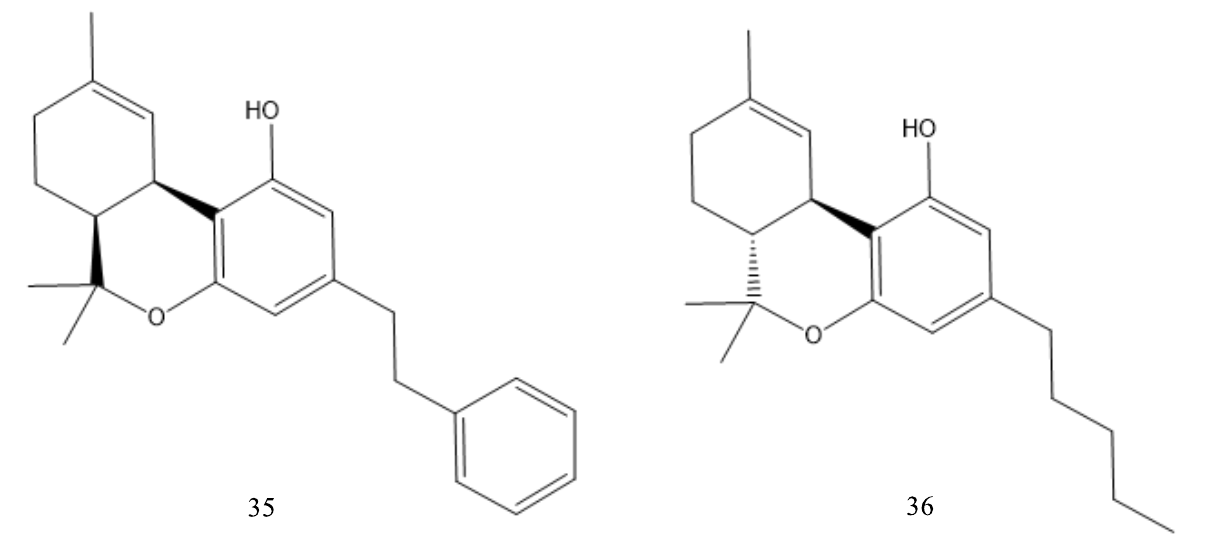
Figure 5. Chemical structures of perrottetinene ( 35) and tetrahydrocannabinol (THC, 36 ).